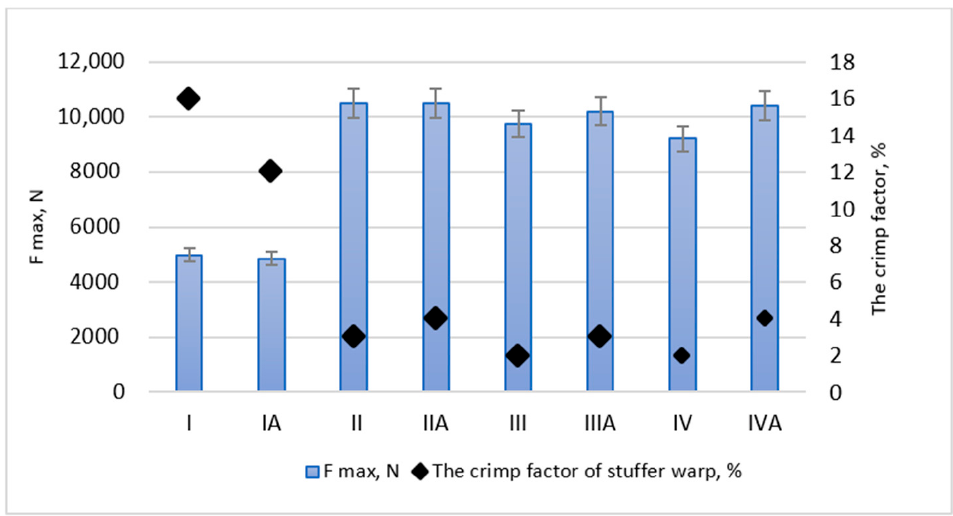
Figure 6. The relationship between Fmax and the crimp factor of stuffer warp.